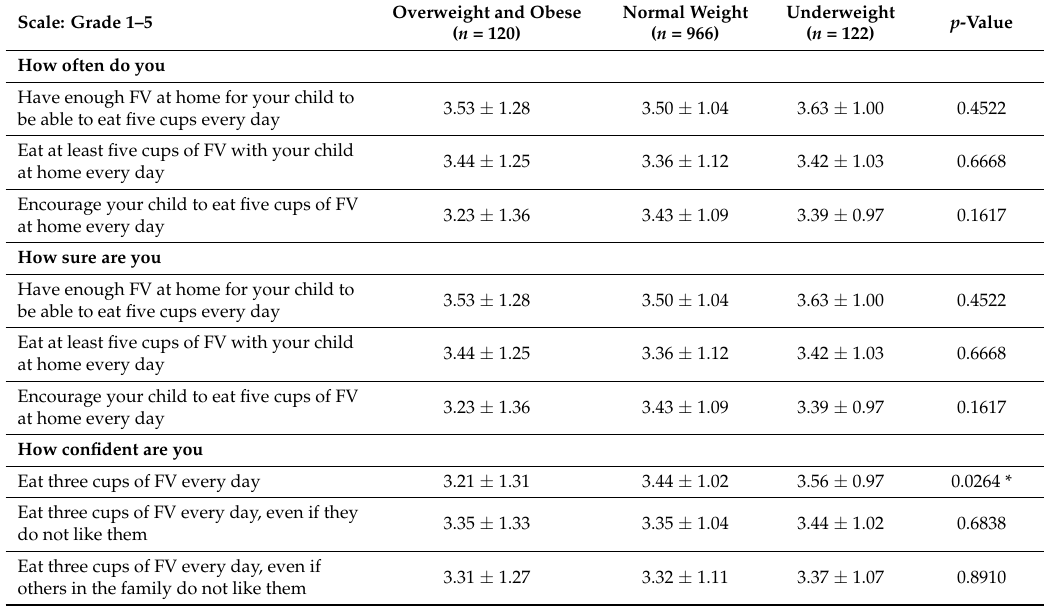
Table 4. Maternal Social Cognitive on Preschool Children’s FV Behaviors by children’ weight